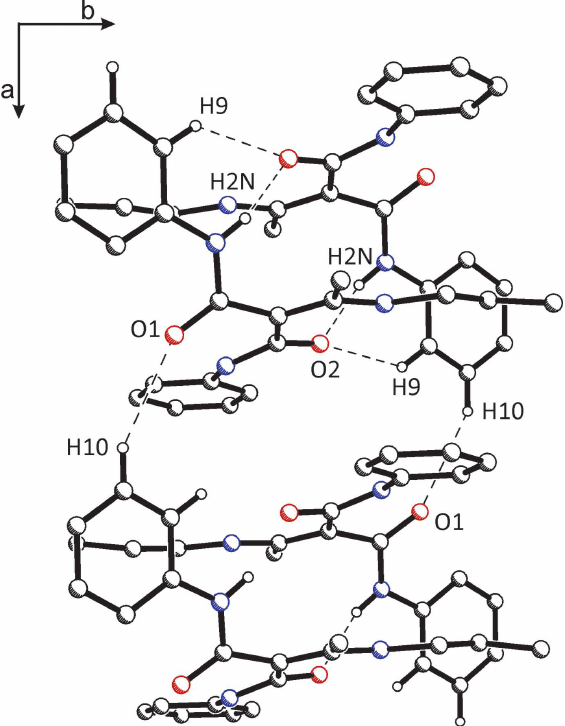
Figure 4 Packing diagram of polymorph ( I ) viewed along the c axis. Intermolecular N—H (cid:2)(cid:2)(cid:2) O and C—H (cid:2)(cid:2)(cid:2) O interactions are